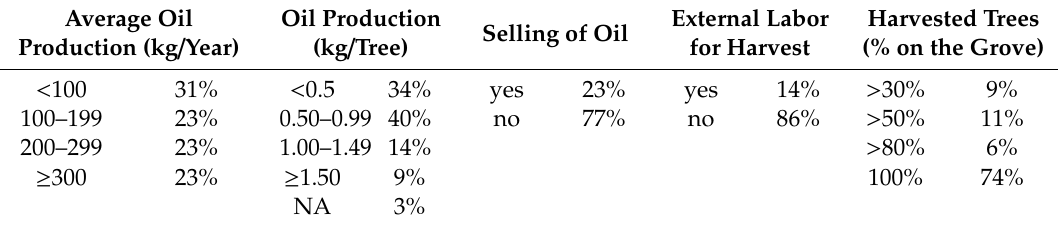
Table 6. Production variables of hobby farmer samples ( n = 35); % refers to the total per item.